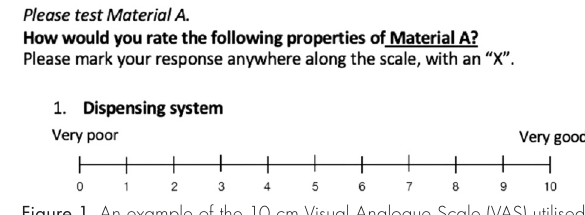
Figure 1. An example of the 10 cm Visual Analogue Scale (VAS) utilised for the